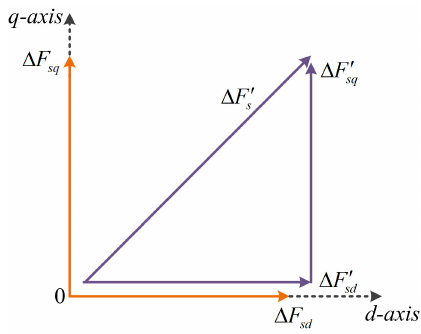
Figure 4. Analysis of error compensational effects.